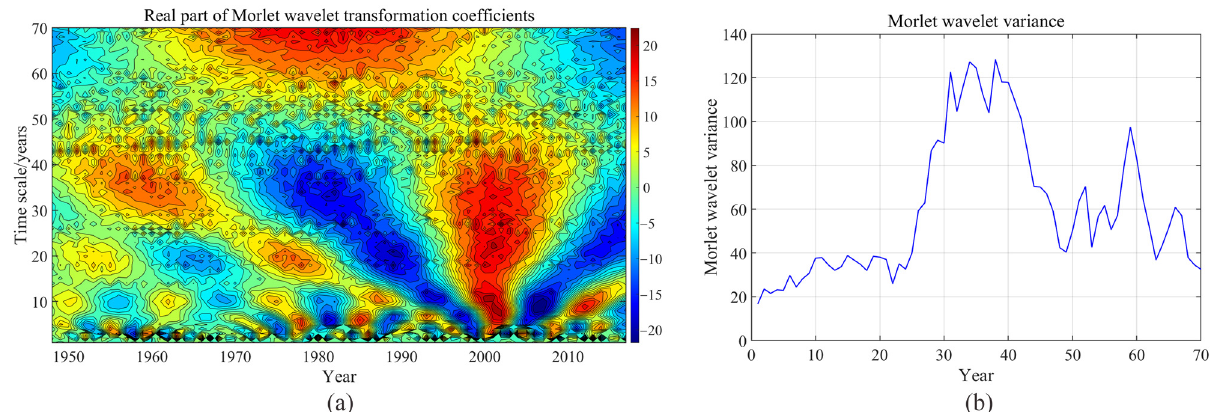
Figure 6. Wavelet analysis results of TWSC in the YZRB from 1948 to 2017. Time–frequency distribution of the real part ( a ) of the Morlet wavelet transform coefficients (red represents a high value of TWSC, and blue represents a low value of TWSC). Wavelet variance map ( b ) (the year corresponding to the peak value is regarded as the main cycle).